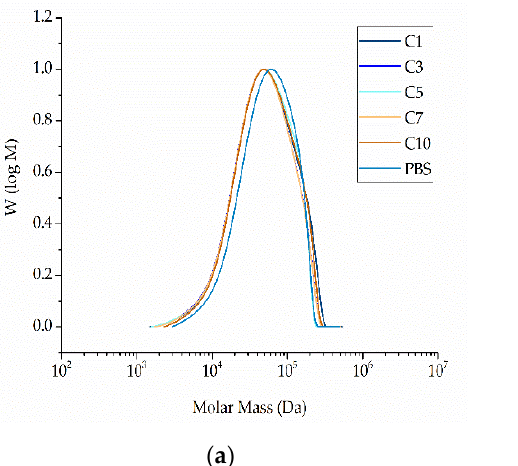
Figure 20. Molar mass distribution curves. ( a ) Fibers composed of PBS compounds with increasing weight percentages of curcumin. ( b ) Fibers composed of PBS compounds with increasing weight percentages of silver. All fibers were prepared by melt electrospinning at 235 °C and 60 kV, with a nozzle-to-collector distance of 10 cm and a throughput of 0.1 mL/min.